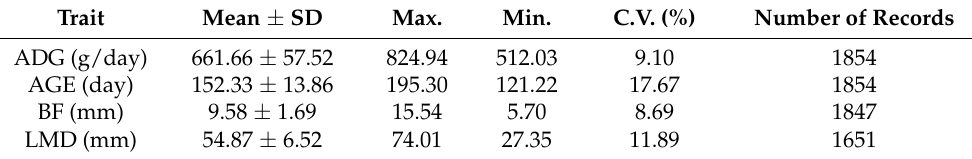
Table 1. Summary statistics for ADG, AGE, BF, and